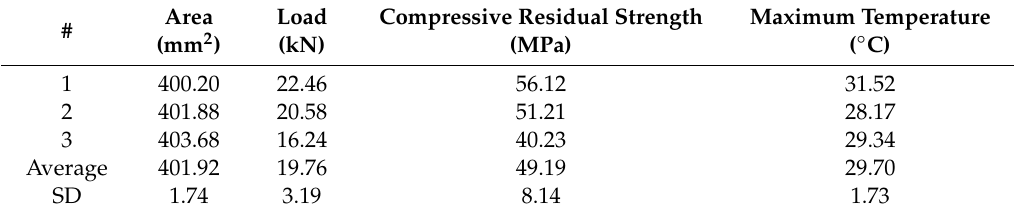
Table 15. CAI test results of Type 5.